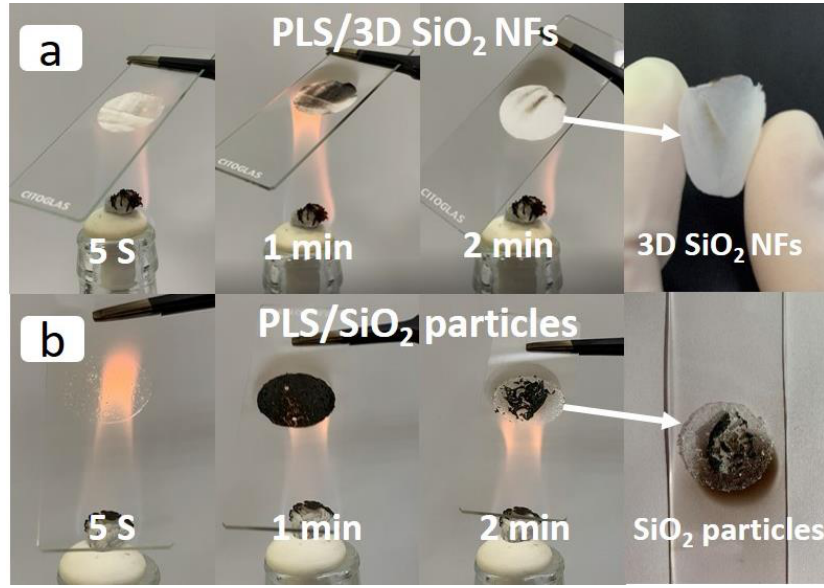
Figure 6. Digital images of PLS/3D SiO 2 NFs ( a ) and PLS/SiO 2 particles ( b ) heated with an alcohol lamp.